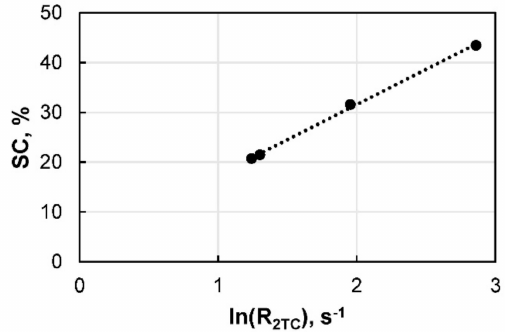
Figure 3. Solids content (SCs) as a function of the spin-spin relaxation rates ln(R 2TC ) corrected to T ref = 60 ◦ C for the black liquor